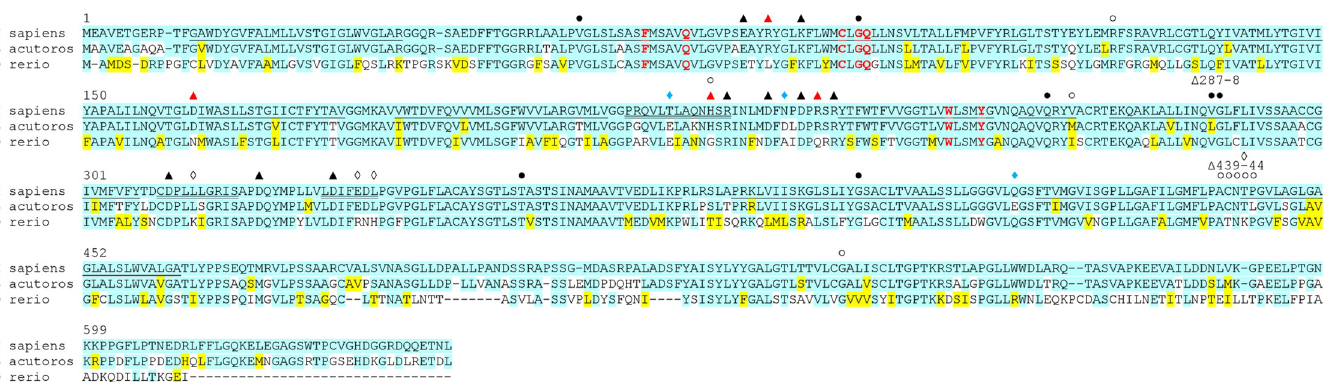
PLOS ONE | https://doi.org/10.1371/journal.pone.0229085 February 21,